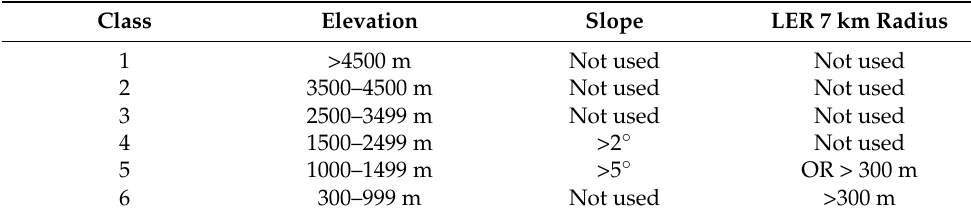
Table 1. UNEP-WCMC criteria for mountain classes.